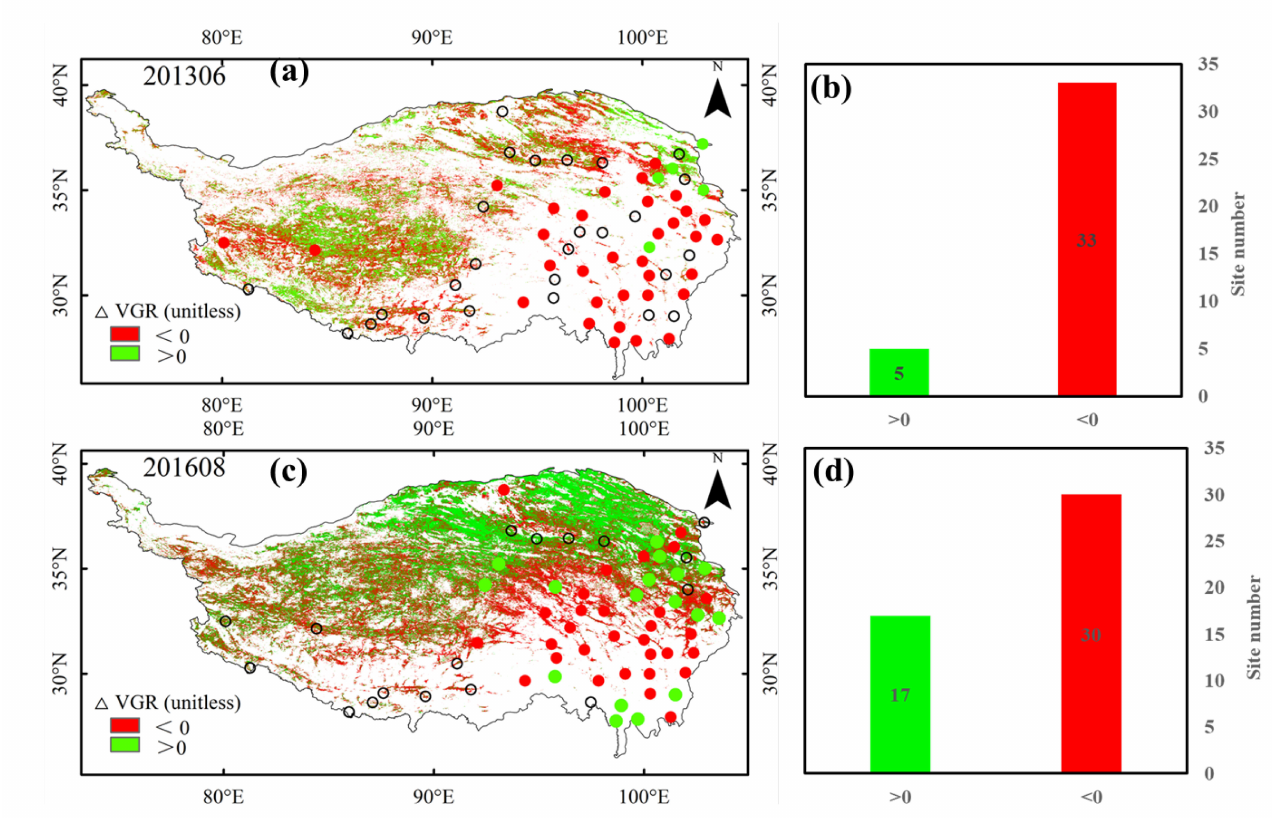
Figure 8. ∆ VGR response to heatwaves in June 2013 ( a ) and August 2016 ( c ). The blank circle represents the site without a heatwave, while the filled circle represents the site with a heatwave; ( b , d ) represent the site number in June 2013 and August 2016, respectively; the red-filled circle represents the negative ∆ VGR; the green − filled circle represents the positive ∆ VGR. Positive ∆ VGR stands for an increase in the VGR; negative ∆ VGR stands for a decrease in the VGR. The right plots illustrate the number of sites with negative and positive